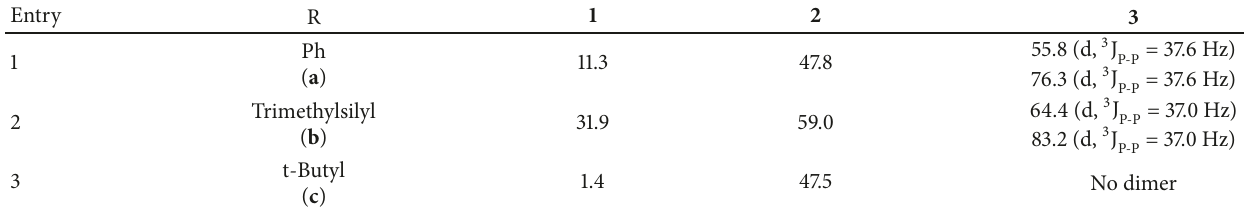
Table 1: 31 P NMR chemical shifts (ppm) (CDCl 3 ) of 1 , 2, and 3 .